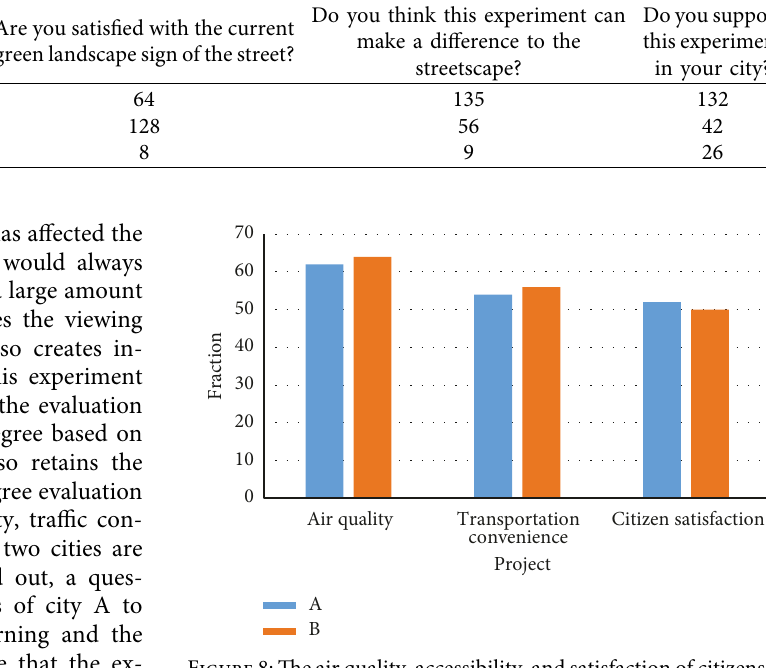
Table 1: Citizens’ awareness of machine learning and the support for this experiment.